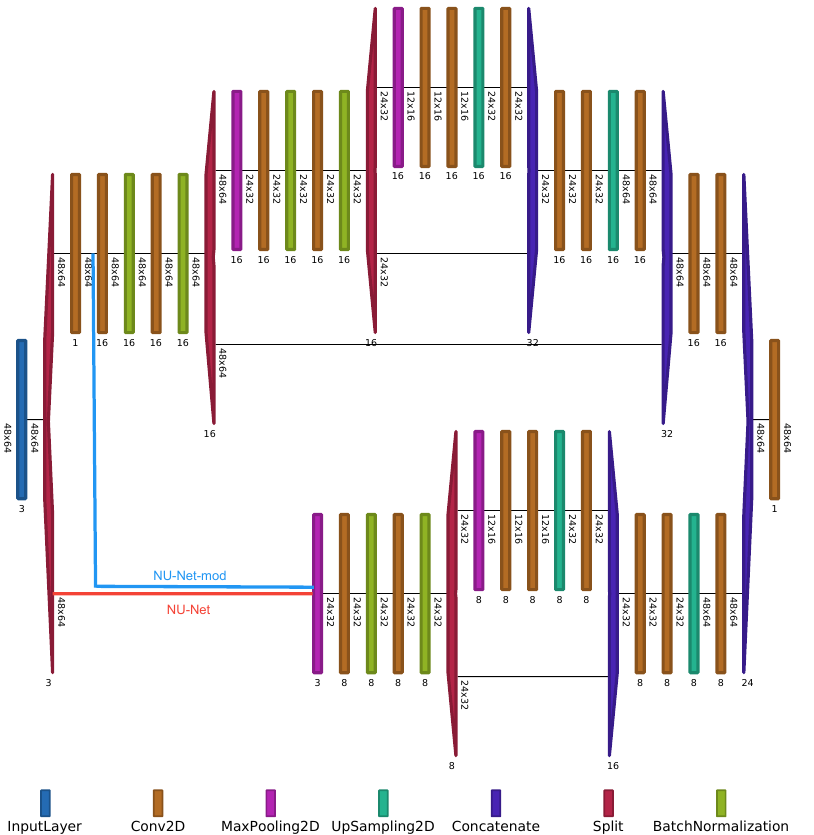
Figure 1. Architecture of NU-Net [24] and Nu-Net-mod visualized using [25]. The blue and red lines show the input of the second stream in NU-Net-mod and NU-Net respectively. The depth of the feature map is denoted at the bottom of each